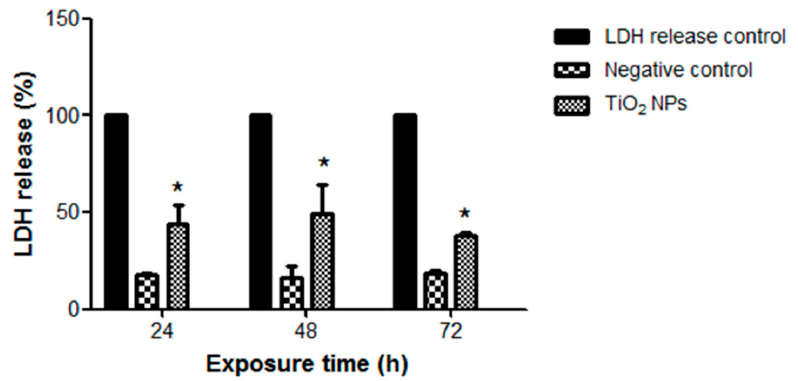
Figure 7. TiO 2 NPs induced LDH release. H9c2 cells were treated with 20 μ g/cm 2 TiO 2 NPs for 24, 48, and 72 h and then an LDH ‐ based cytotoxicity assay was performed. Results are presented as mean ± standard deviation (SD) of three independent experiments ( n = 3). * Significant difference between negative control (untreated) and treated cells ( p < 0.05).